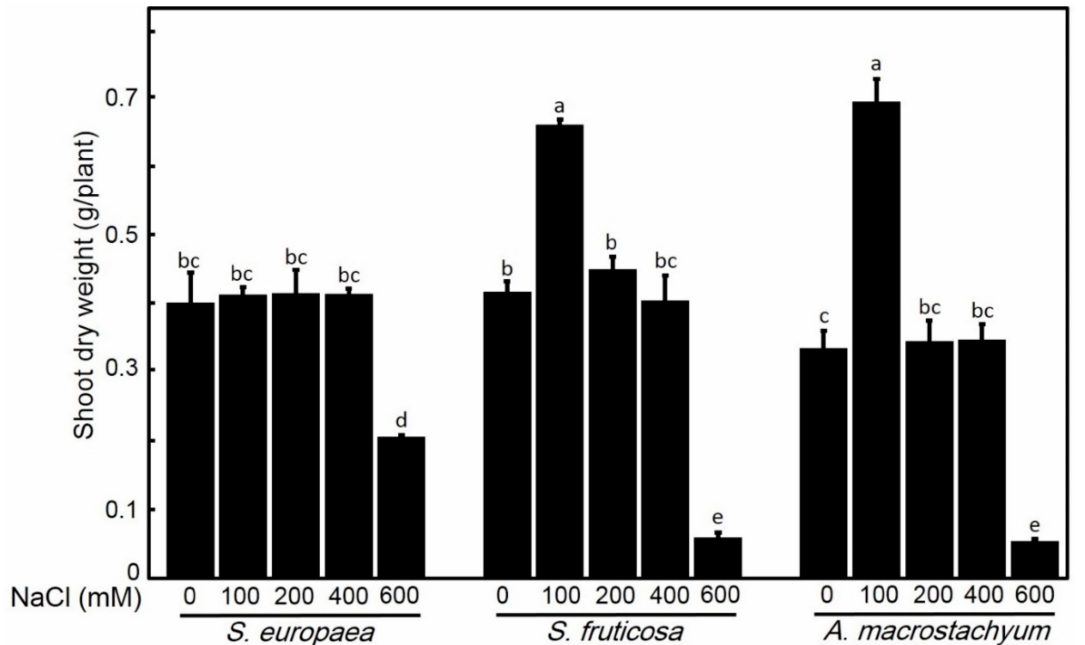
Figure 3. Shoot dry weights of S. europaea, S. fruticosa and A. macrostachyum under different NaCl concentrations. Mean ± SE of three replicates. Different letters indicate significant differences ( p < 0.05).